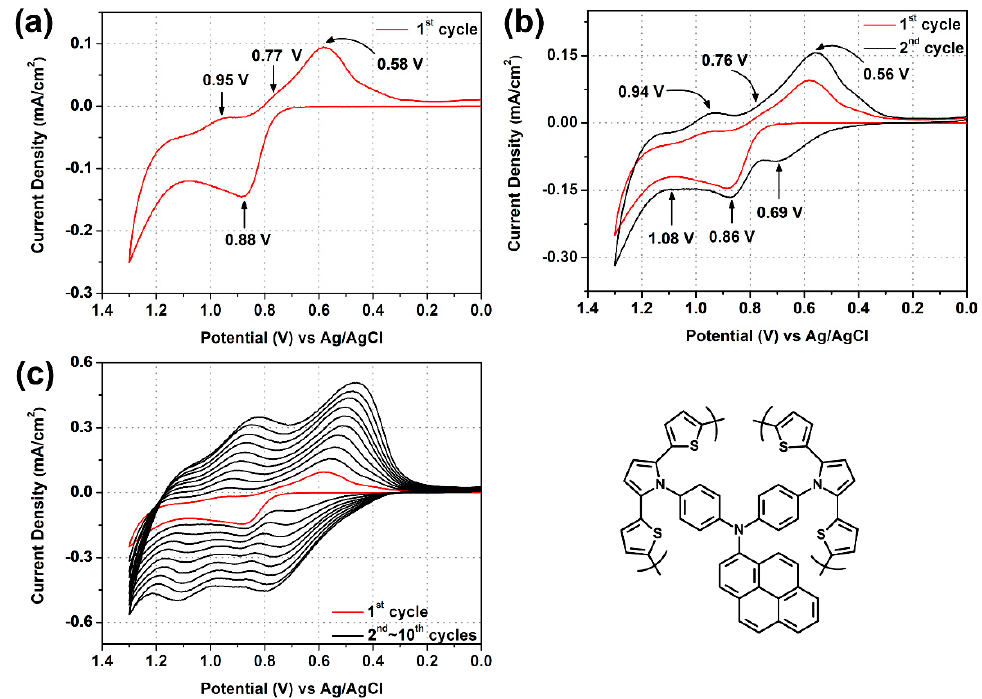
Figure 5. ( a ) The first CV scan, ( b ) the first two second CV scan, and ( c ) ten repetitive CV scans of 0.2 mM of DPPA-2SNS in 0.1 M Bu 4 NClO 4 / CH 2 Cl 2 in the potential range of 0.00–1.30 V at a scan rate of 50 mV / s.